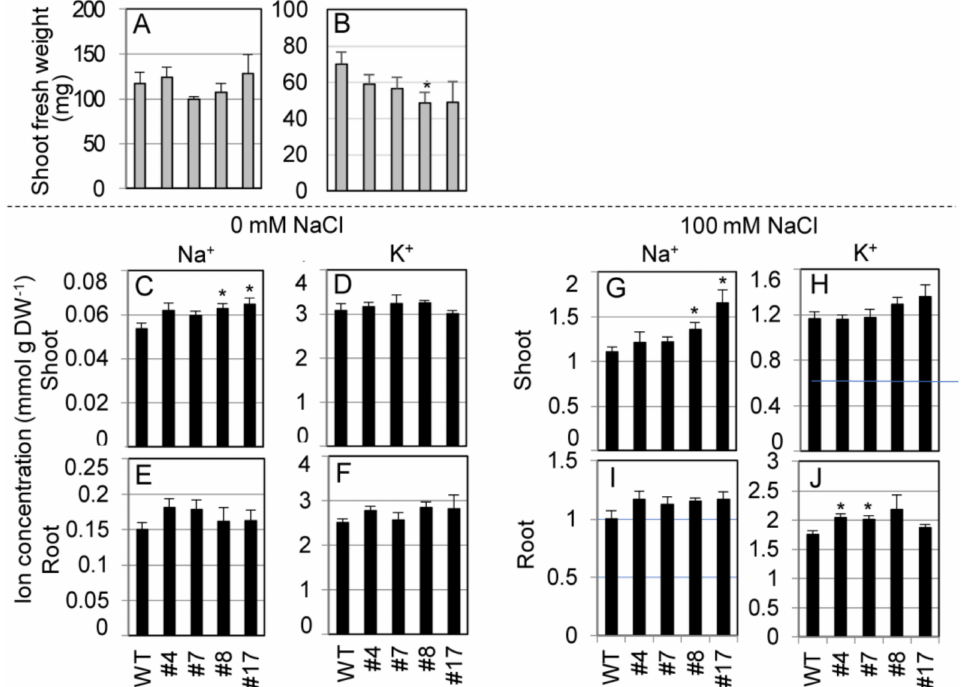
Figure 7. Shoot fresh weight and ion concentrations of SvHKT1;1 transgenic lines and WT plants. ( A , B ) Shoot fresh weight of WT plants and the transgenic lines. Two-week-old seedlings germinated on 1 / 2 MS agar medium were hydroponically cultured in 1 / 2 MS liquid medium for another one week, and then cultured in 1 / 2 MS medium supplemented with 0 ( A ) or 100 mM ( B ) NaCl, and their FW was determined after one week. ( C – J ) Ion concentrations in WT plants and the transgenic lines. Na + ( C , E , G , I ) and K + ( D , F , H , J ) concentrations in their shoots ( C , D , G , H ) and roots ( E , F , I , J ) were determined. Data are presented as means ± SE ( n = 3–4 biological replicates). Please note that each panel has a di ff erent Y -axis scale. Single and double asterisks denote significant di ff erences